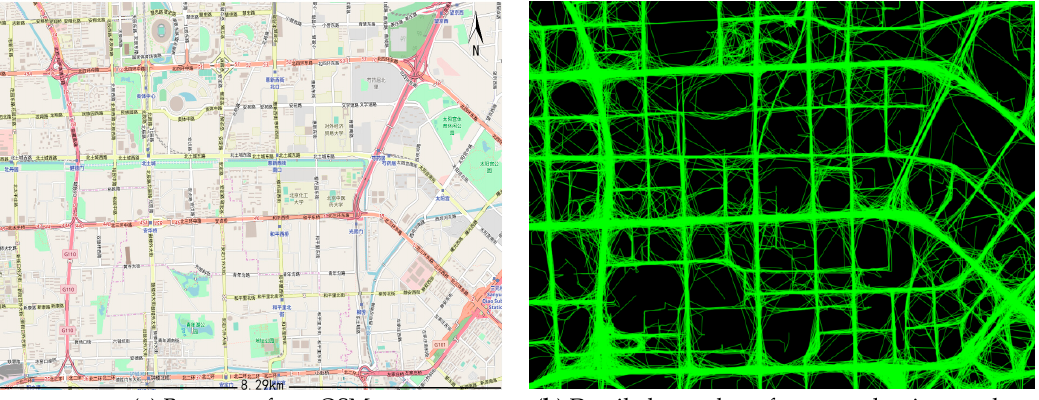
Table 3. Statistics of the resulting digital map. Figure 6. Base map and snapshots for the preprocessing trajectory data from Beijing. ( a ) A base map from OpenStreetMap. ( b ) A visualization of 5.76 million raw trajectory data points using OpenCV. ( c ) A visualization of those trajectory data after time filter 0 s < Δ t < 600 s. ( d ) A visualization of the trajectory data after preprocessing. As shown in the picture, our preprocessing algorithm can effectually remove noise.